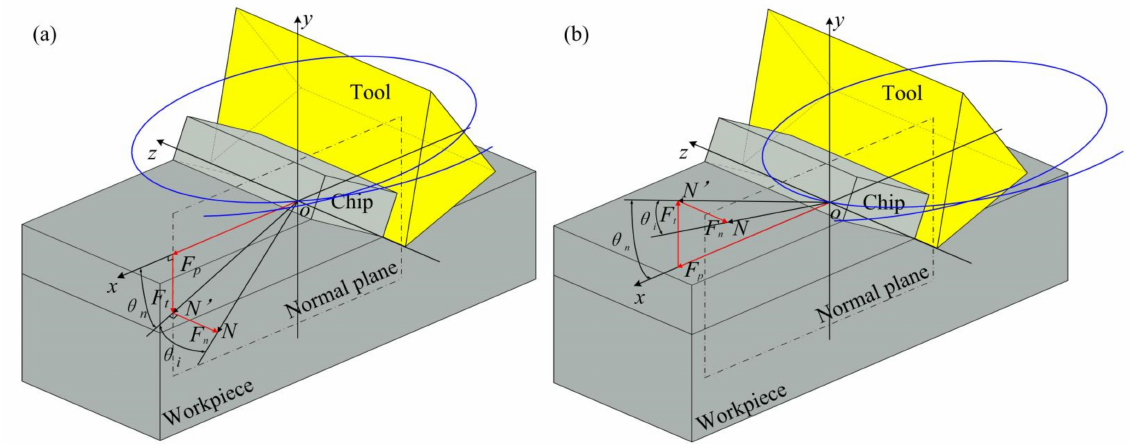
Figure 4. Analysis of the cutting force of the cutting tool acting on the workpiece ( a ) the stage similar to ordinary cutting ( b ) the stage of friction